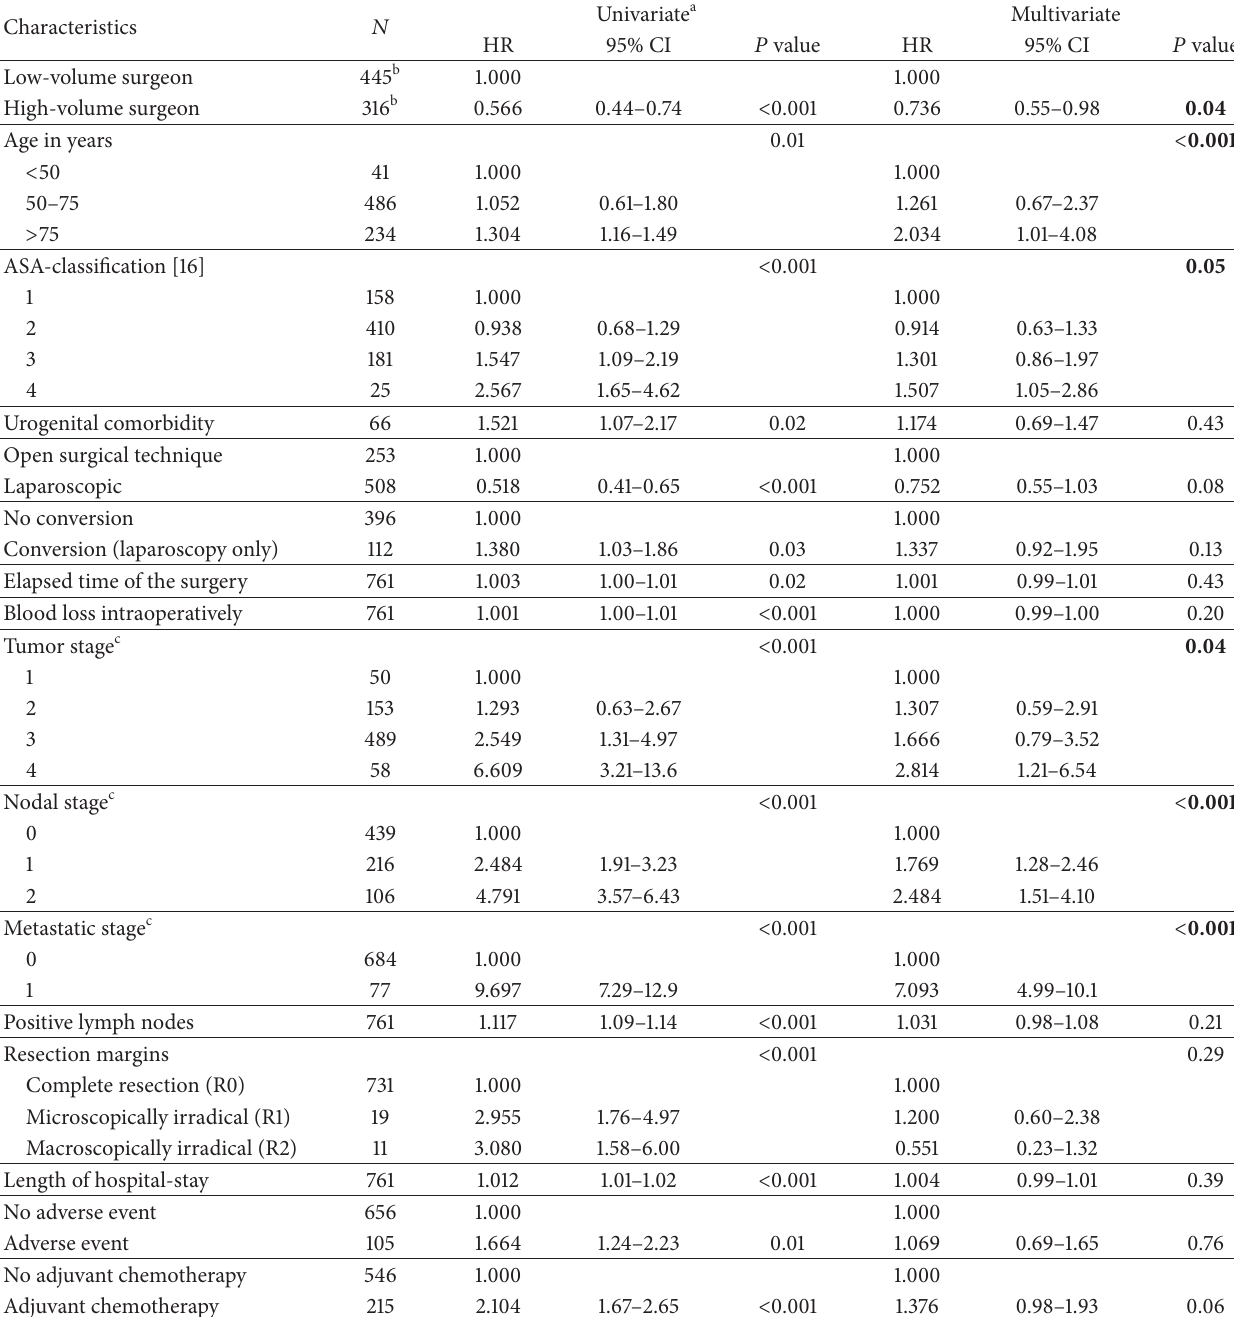
Table 4: Univariate and multivariate analysis of disease-free